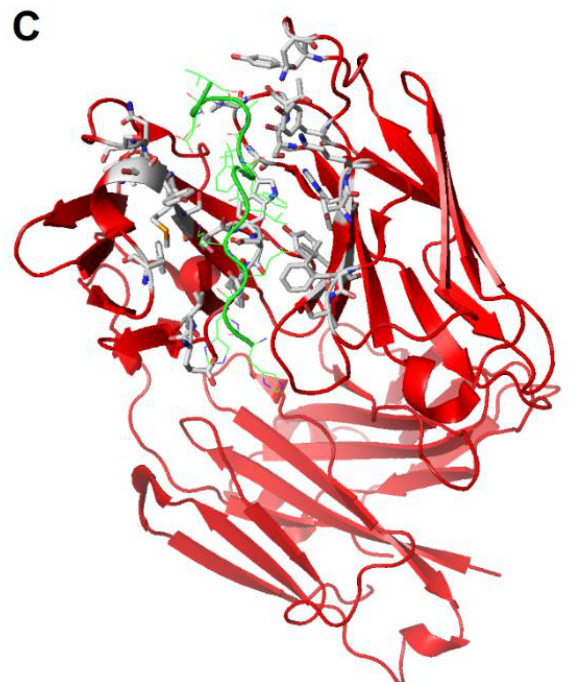
Figure 3. Three representative complexes of anti-amyloyd molecules with their respective targets: ( A ) TTR binding sites in the presence of tolcapone, with ligand shown as solvent accessible surface. For clarity, H 2 O oxygen atoms are shown as spheres with 50% of the van der Waals radius (PDB code 4D7B); ( B ) TTR binding sites in the presence of mds84, with ligand shown as solvent accessible surface as above (PDB code 3IPE); ( C ) crenezumab Fab in complex with A β , with backbones of the interactors coloured in red and green, respectively. Carbon atoms of selected side chains in the Fab are coloured in grey, whereas those belonging to A β are green (O, red; N, blue; S, yellow; PDB code: 5VZY). The pictorial representations in panels ( A ), ( B ) were taken from Ref. 134 and licensed under a Creative Commons Attribution 4.0. The image in panel ( C ) was created by means of PyMOL (v. 0.98), using the set of atomic coordinates available in the Protein Data Bank.